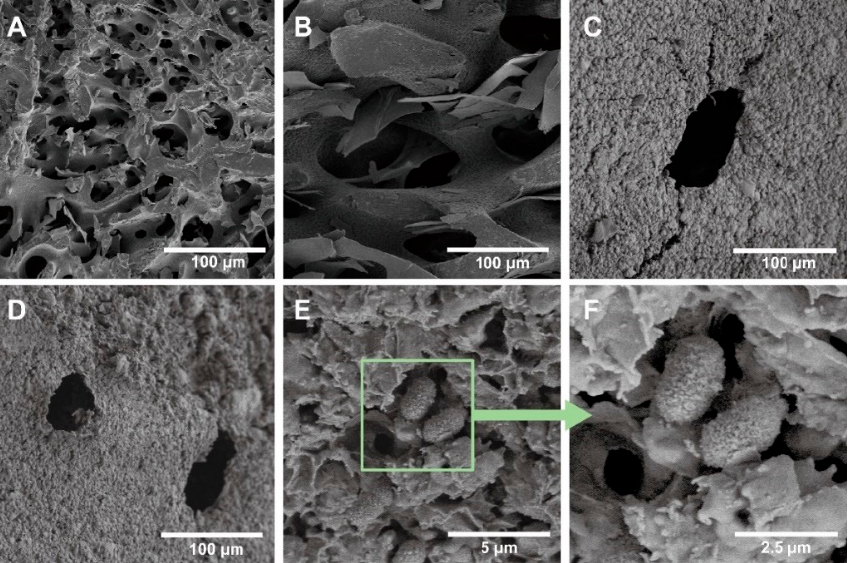
Figure 13. The SEM images of different samples. The cross-sectional images of ( A ) printed WES and ( B ) unprinted WES samples. Surface images of ( C ) printed WES and ( D ) unprinted WES samples. ( E ) The nitrifying bacteria in WLS, and the enlarged picture is shown in ( F ).